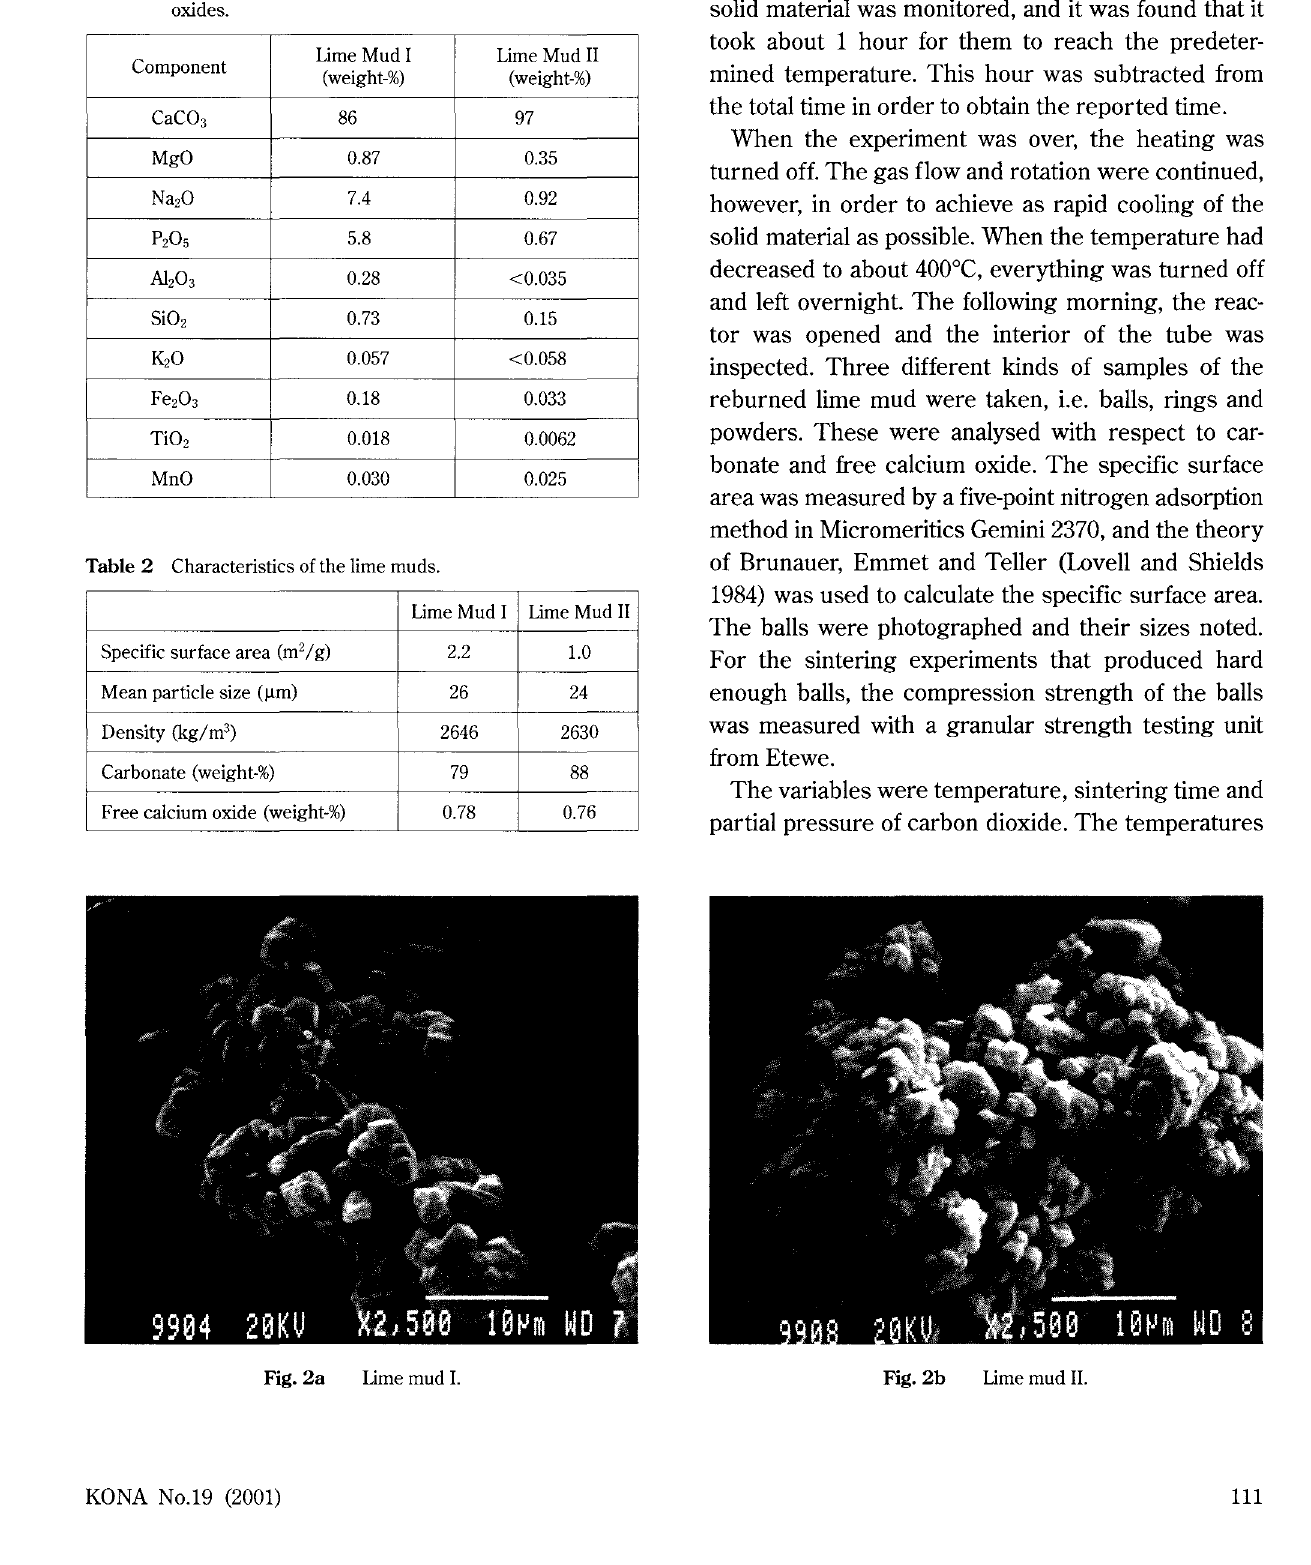
Table 1 Composition of the dried lime muds. The elements, with the exception of calcium, are expressed as their related oxides.